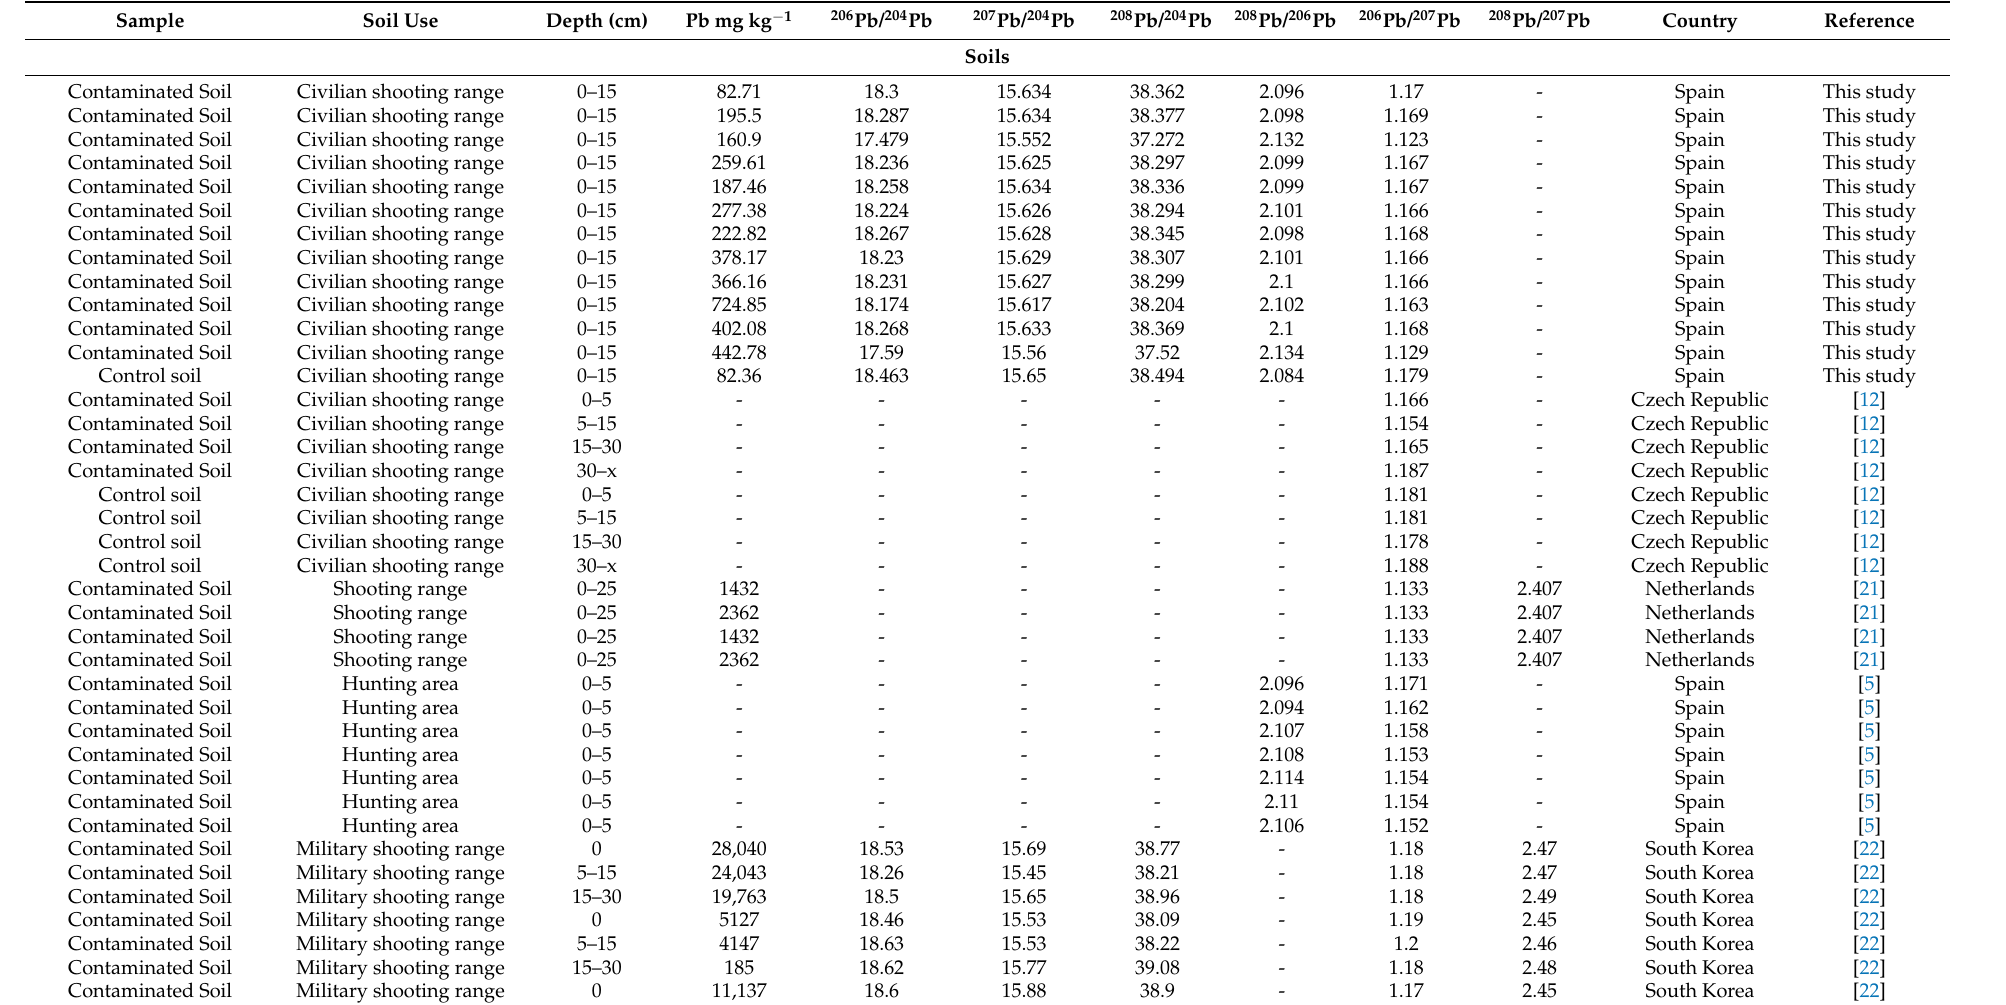
Table 1. According to the literature, lead stable isotopes ratios from different shooting range soils and soil sediments near shooting and hunting areas. Measurement precision is indicated according to the different studies—average